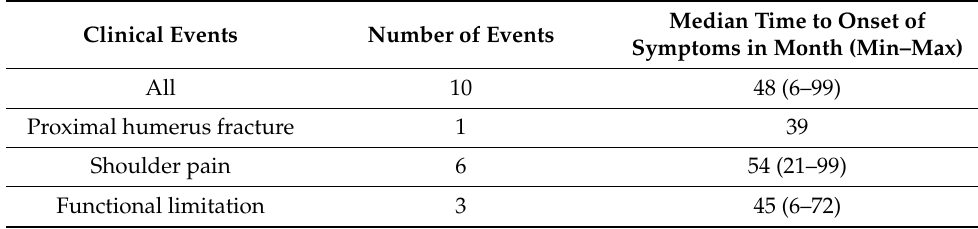
Table 2. Number of clinical events by subtypes (proximal humerus fracture, shoulder pain and functional limitation) and median time to the onset of